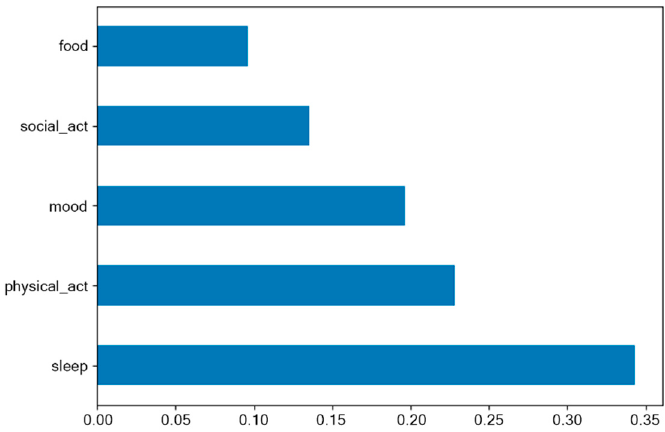
Figure 7. Distribution of feature importance for depression classification model.